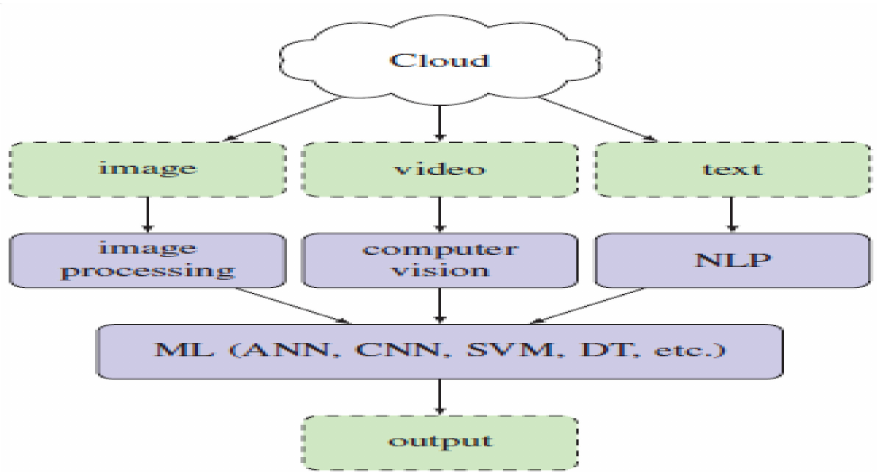
Figure 23. Framework from heterogeneous sources in intelligent transportation [150].